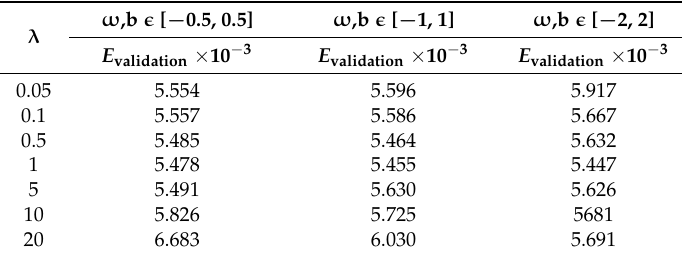
Table 2. Effects of different ranges of λ and ω , b on model